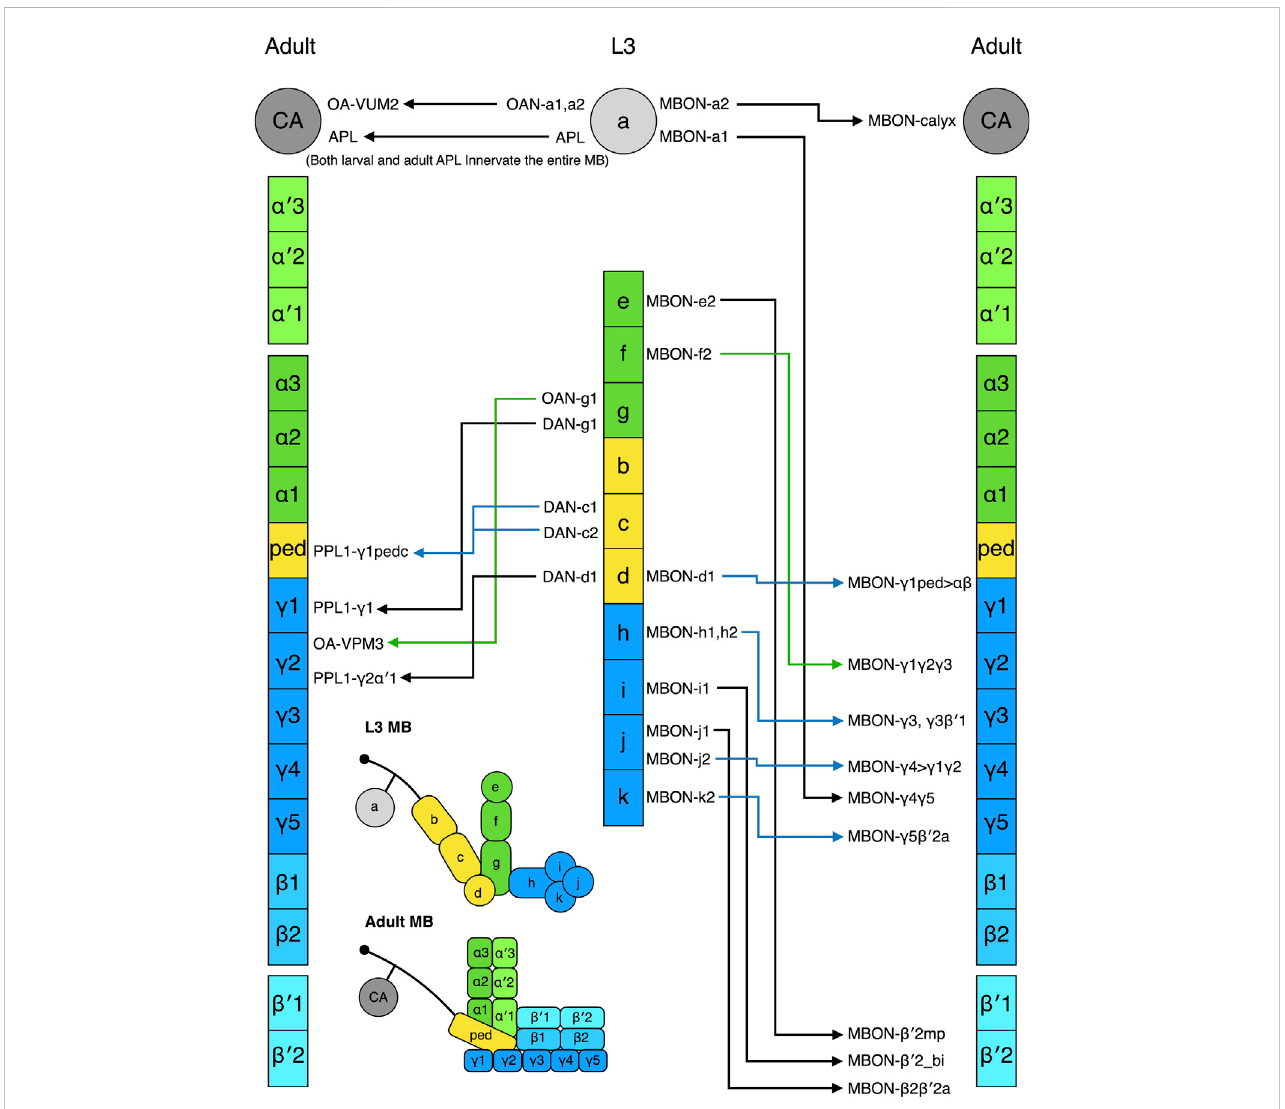
FIGURE 5 Metamorphosis of MB extrinsic neurons. The L3 MB extrinsic neurons that are remodeled into the adult MB extrinsic neurons are shown. The neurons havebeenpositionedinfrontoftheMBzoneswheretheirneuritesinnervate.Someneuronsinnervatemultiplezones;insuchcases,theyhavebeenplacedin front of one of their innervating zones. The nomenclature of the neurons follows the de fi nition provided in Figure